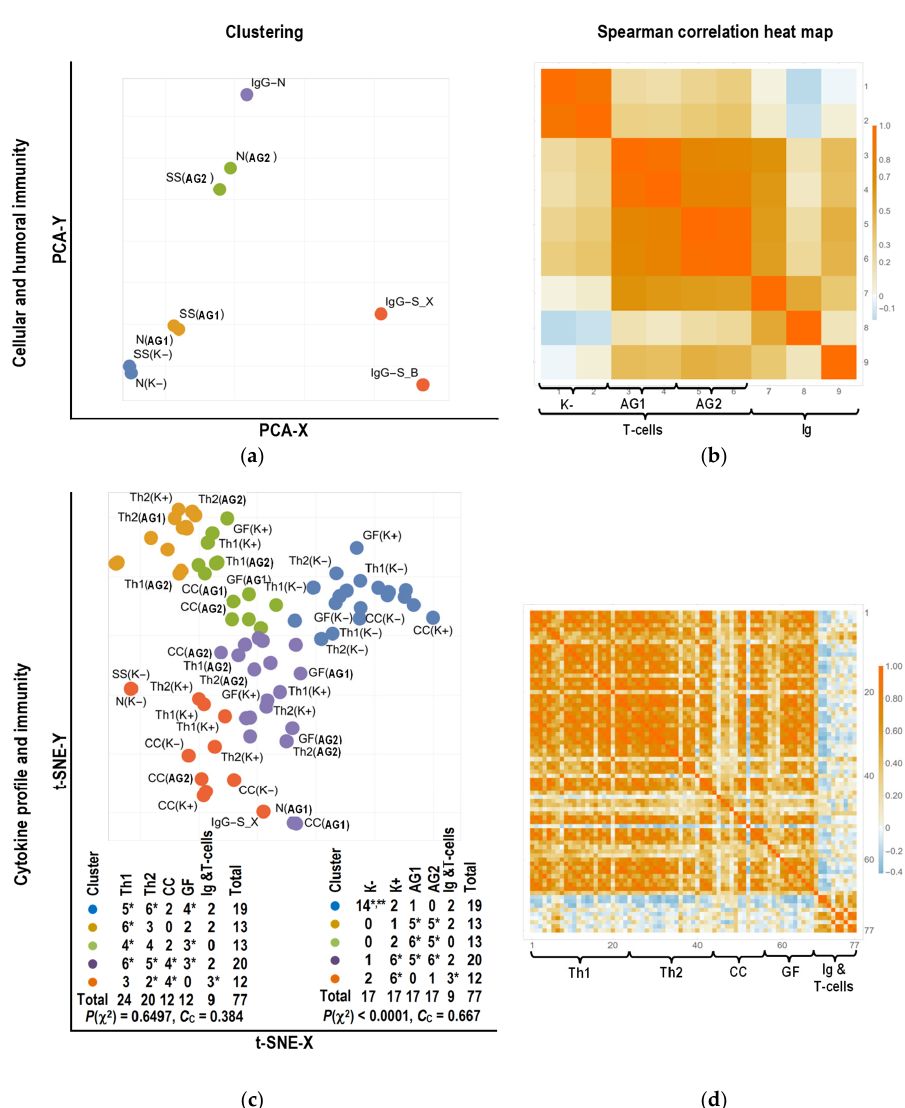
Figure 8. Bioinformatics analysis with clustering of cellular (T ‐ cells) and humoral (Ig) immunity parameters and cytokine profile of individuals. ( a , c ) Clustering results; ( b , d ) Spearman rank correlation coefficient heat diagrams. In images with clustering results, circles of the same color indicate parameters of the same cluster. The designations near the circles represent the group of cyto ‐ kines (Th1, Th2, CC, GF), cellular (N, SS) and humoral (IgG ‐ S, IgG ‐ N) immunity; the activation used (K+, AG1, AG2) or its absence (K − ) is specified in brackets. The insertions in the lower clustering diagram show contingency tables with different groupings of indicators. * The proportion of parameters in the cluster significantly exceeds 0.05 of the number of parameters belonging to the specified group ( p < 0.01). ** The proportion of parameters in the cluster significantly exceeds the proportion of parameters belonging to the specified group in other clusters ( p < 0.01).